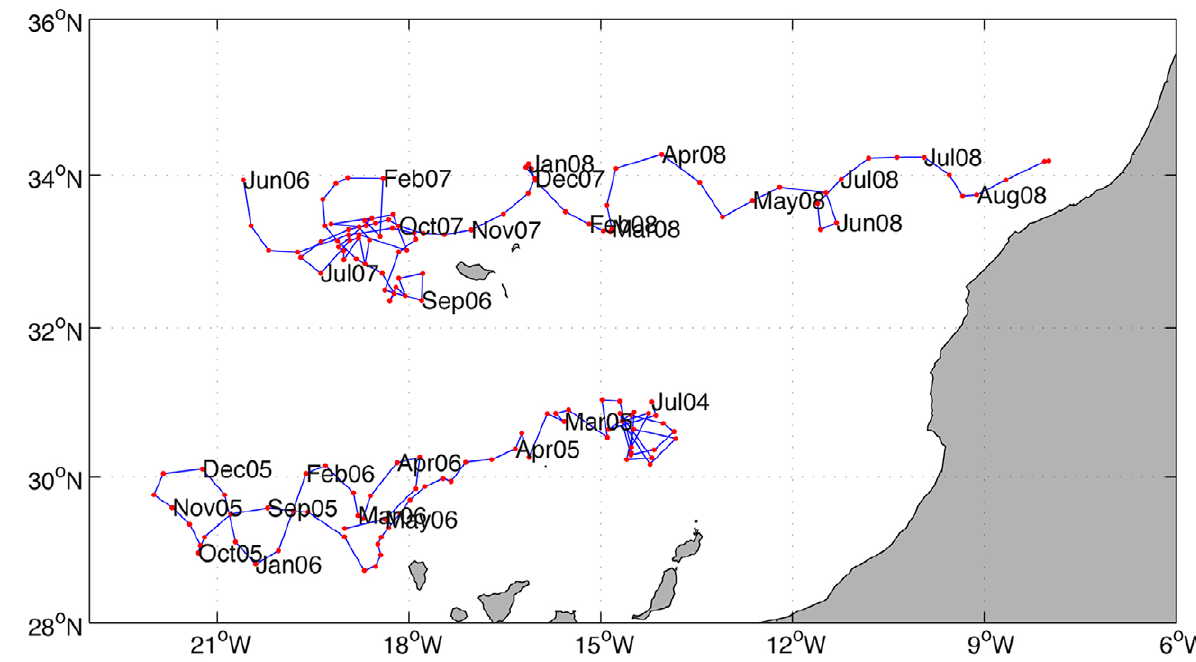
Fig. 2. – Trajectories of two Argo floats that tracked two meddies while drifting at 1000 dbar in the region north of the Canary Islands; these meddies, which were initially detected and tracked in 2005 and 2007, are respectively named F04 and F07. The dots represent data points every time the float surfaced, approximately every 10 days, with the start of each calendar month